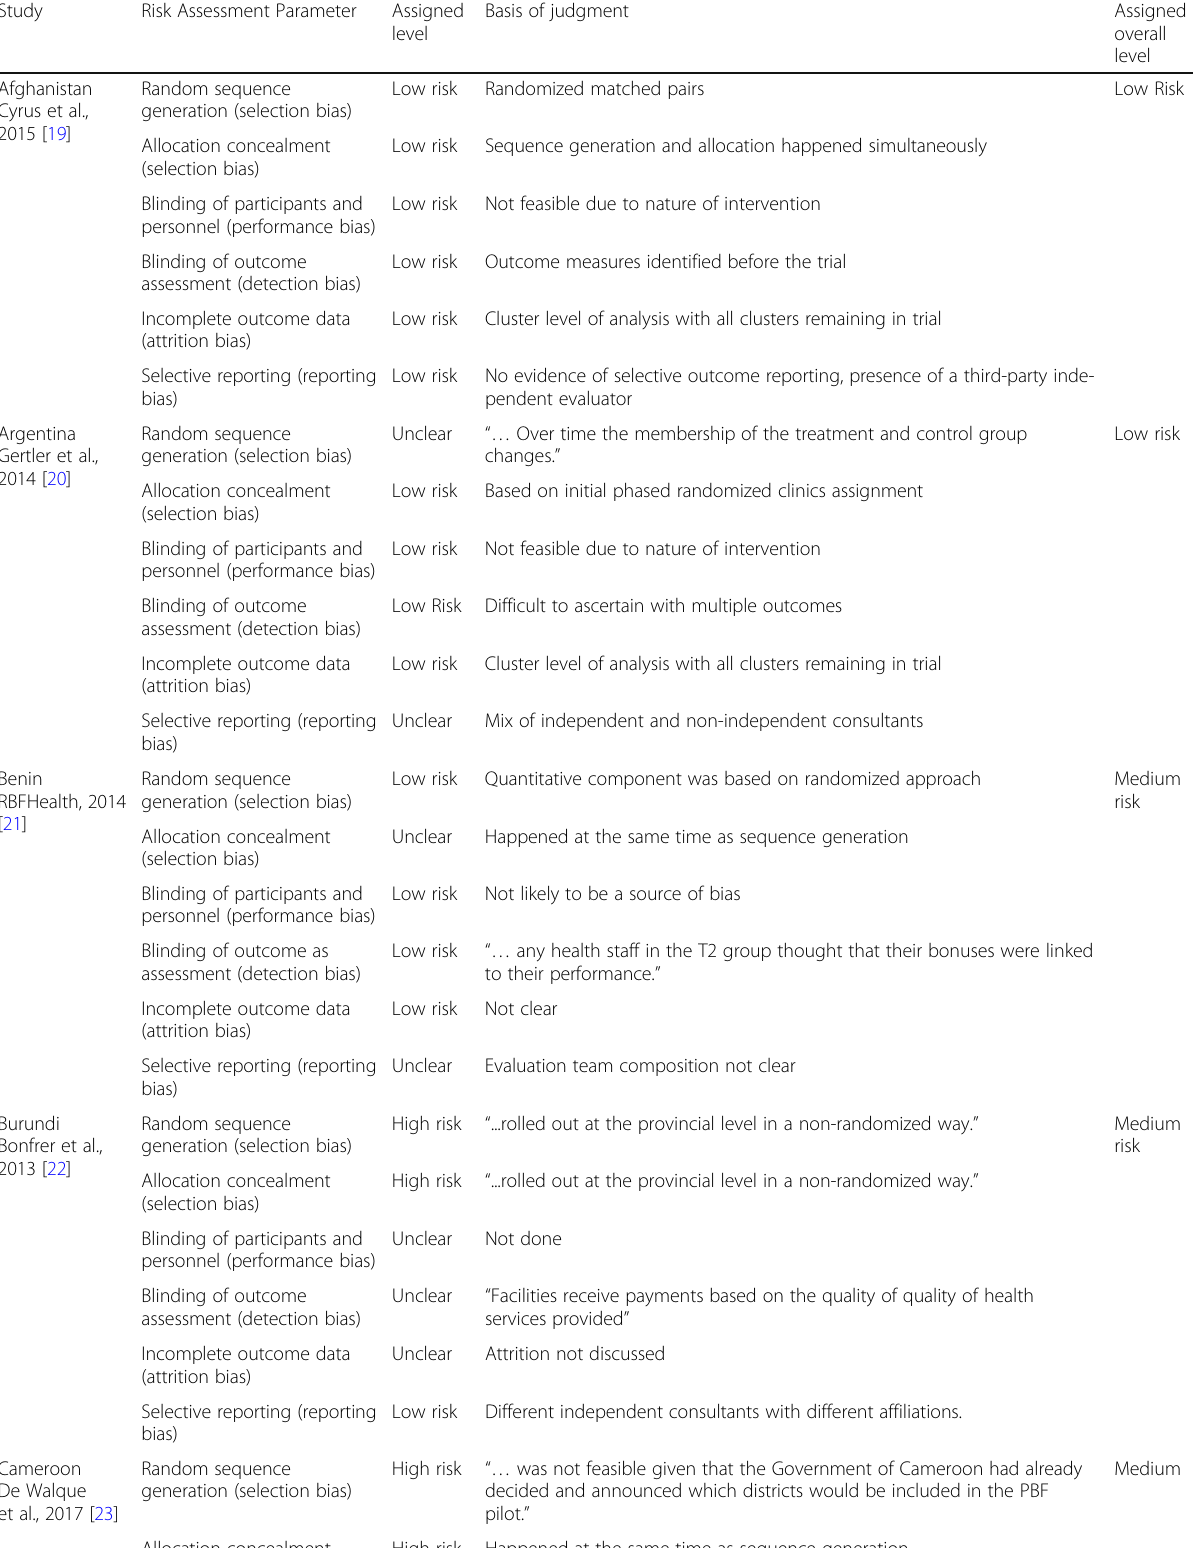
Table 3 Risk of bias